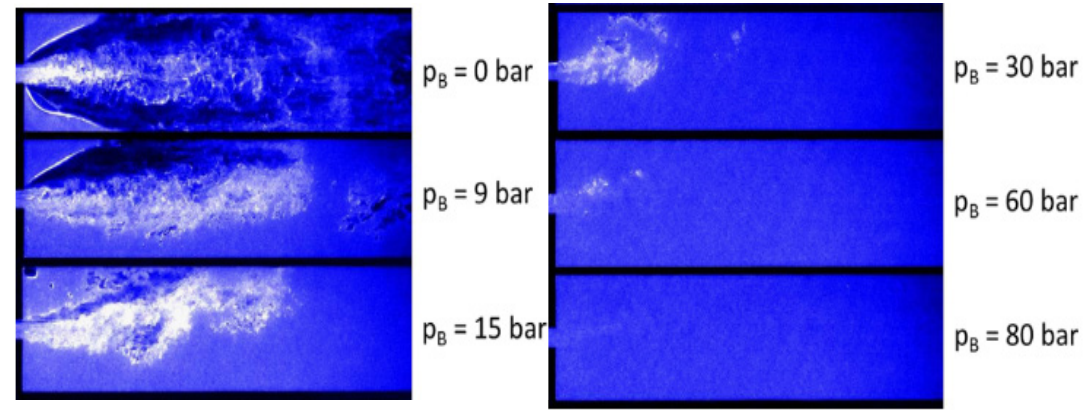
Figure 8. Hydrodynamic cavitation images downstream of the HPMS orifice. The pressure difference was constant at ∆ p = 200 bar while the backpressure was increased. Dark blue corresponds to low fluorescent intensity and high vapour concentration, whereas white corresponds to high fluorescent intensity and the boundary between vapour and liquid. Light blue corresponds to the liquid. Reproduced with the permission from [42]; Elsevier, 2016.